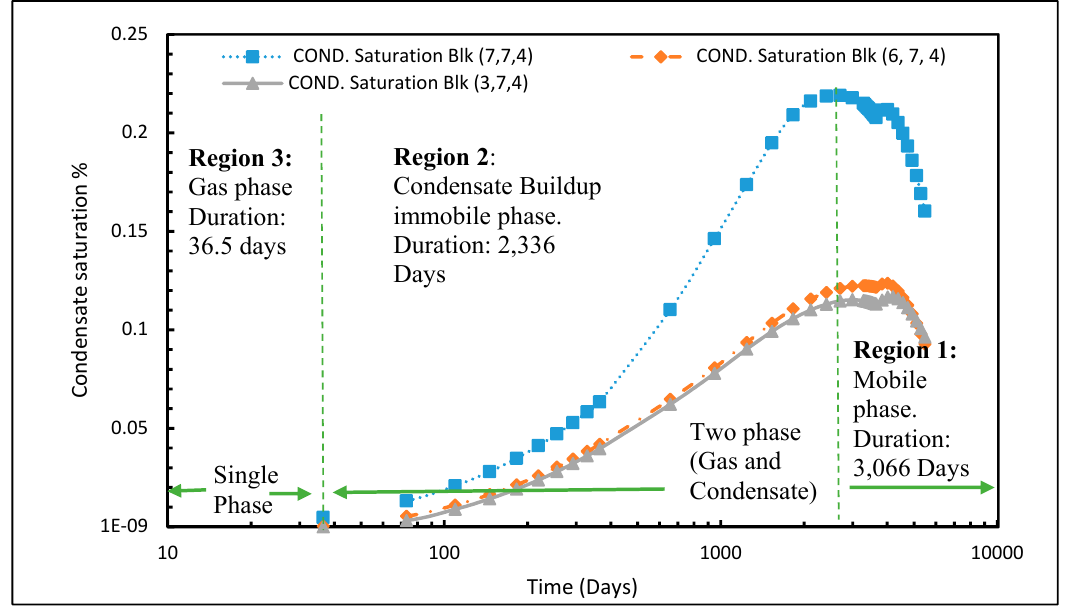
Figure 9. Condensate saturation against time and cell block location (three locations) for gas recycling showing the different phases for three distinct regions and locations during production.